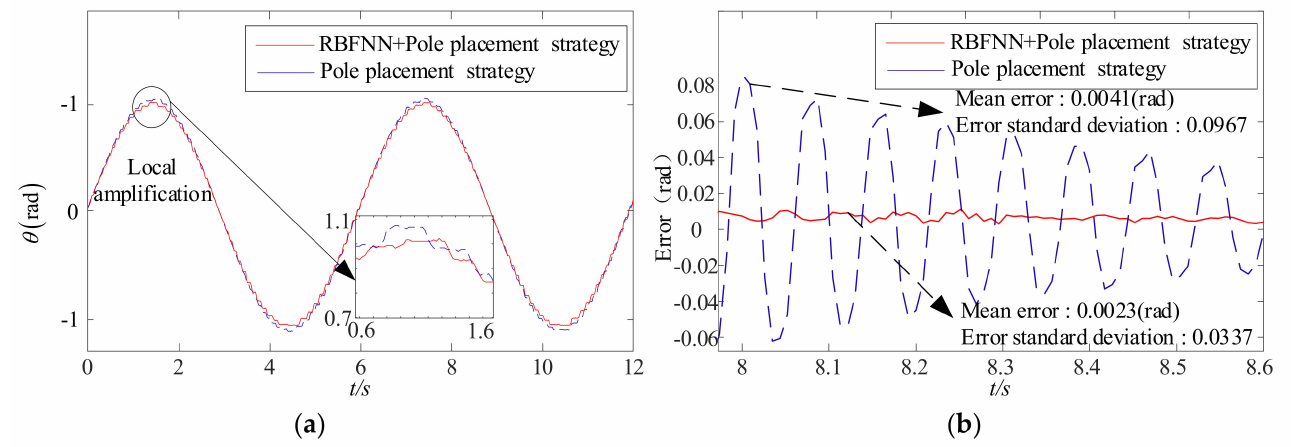
Figure 16. Control experiment results. ( a ) Rotation angle. ( b ) Error.